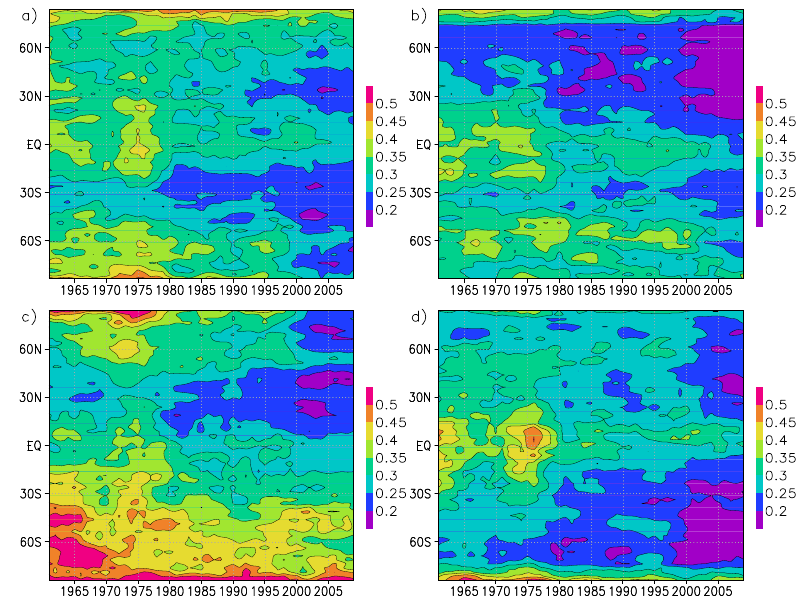
Figure 11. Five-year sliding average of the normalized mean of the absolute values of the next-amplitude difference for the months January